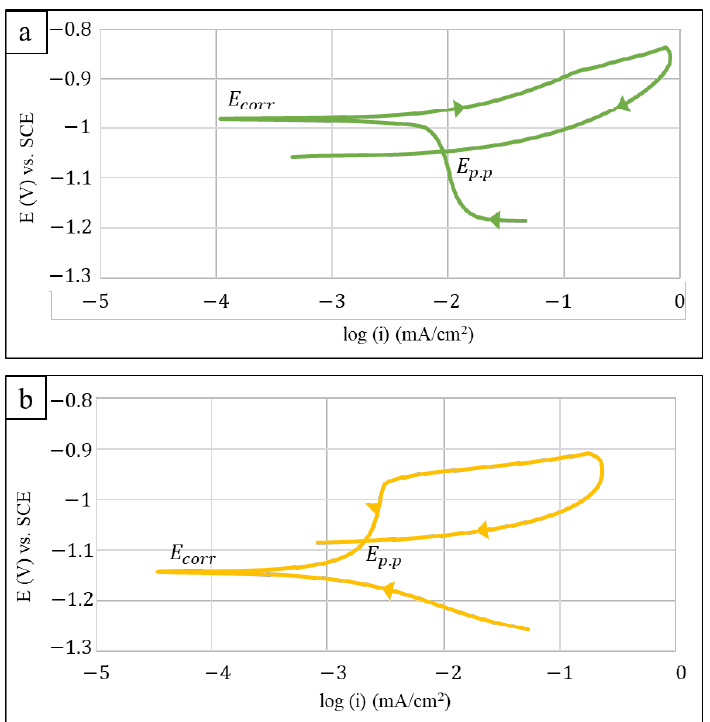
Figure 5. Cyclic potentiodynamic polarization analysis in PBS solution ( a ) hybrid Ti-Zn system ( b ) Zn-2%Fe alloy.